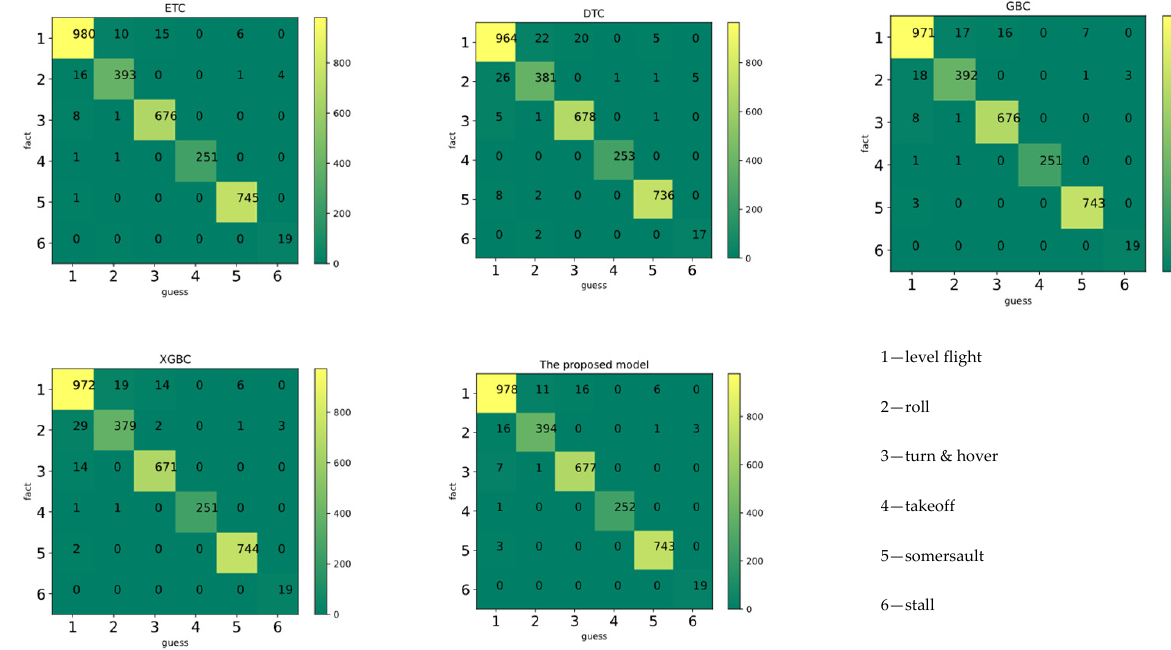
Figure 8. The importance ranking of the four different classifiers. Removing irrelevant features can help to ease the learning task, make the model simple and reduce the computational complexity. Based on the importance ranking, we chose to keep NN, SDNN, pNN50, pNN20, VLF, LF, HF, RESP, RESP mean, RESP standard deviation, SC, SC mean, SC standard deviation, EMG mean, EMG standard deviation, EMG RMS, iEMG, EMG median frequency, and EMG mean power frequency as features. After the features were selected and re-input into the model, the classification performance was as shown in Figure 9 and Table 9. It was found that, after feature selection, the performance of all models improved.